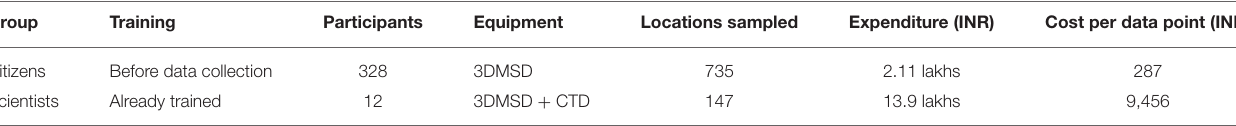
TABLE 3 | Comparison of the relevant variables and cost associated with data collection using 3DMSD by citizens and scientists.